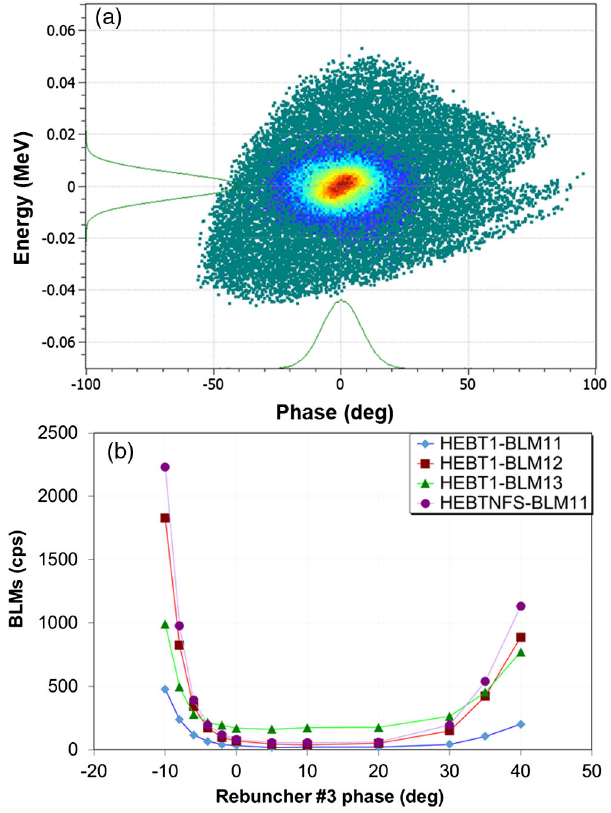
FIG. 9. (a) Longitudinal acceptance of the SC linac and (b) measurement of the losses for the HEBT line as a function of rebuncher #3 phase.